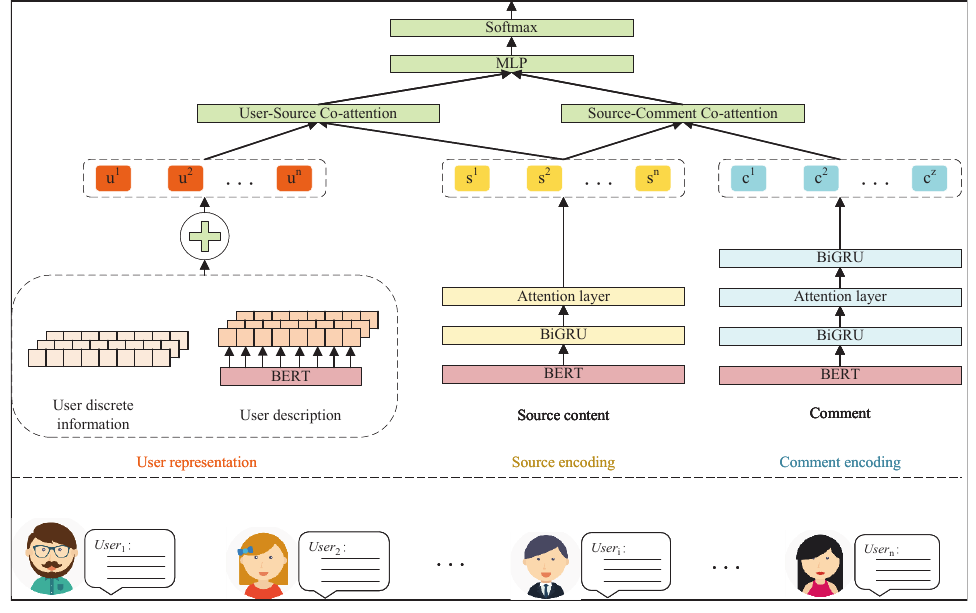
Figure 1. Overall network model